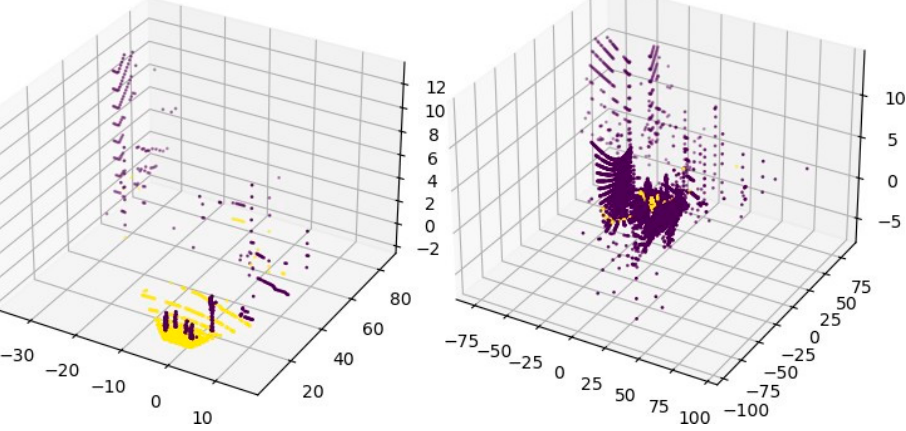
Figure 13. RANSAC regression applied to 3D point cloud